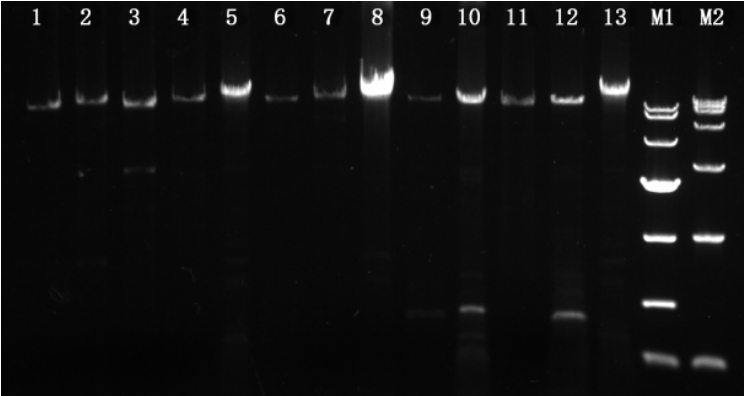
Figure 1. Agarose gel electrophoresis of PCR products of the mating idiomorphs. Lane 1, 3, 5, 7, 9, 11: PCR products from the MAT1-2 type strains YAASMQM-4, YAASMHL47, YAASM23-22, YAASM131-12, YAASM50-09, and YAASM43-08; Lane 2, 4, 6, 8, 10, 12: PCR products from the MAT1-1 type strains YAASMQM-23, YAASMHL1, YAASM23-11, YAASM131-9, YAASM50-38, and YAASM43-24; Lane 13: PCR products from strain YAASMVR; M1: DL10000 DNA Marker